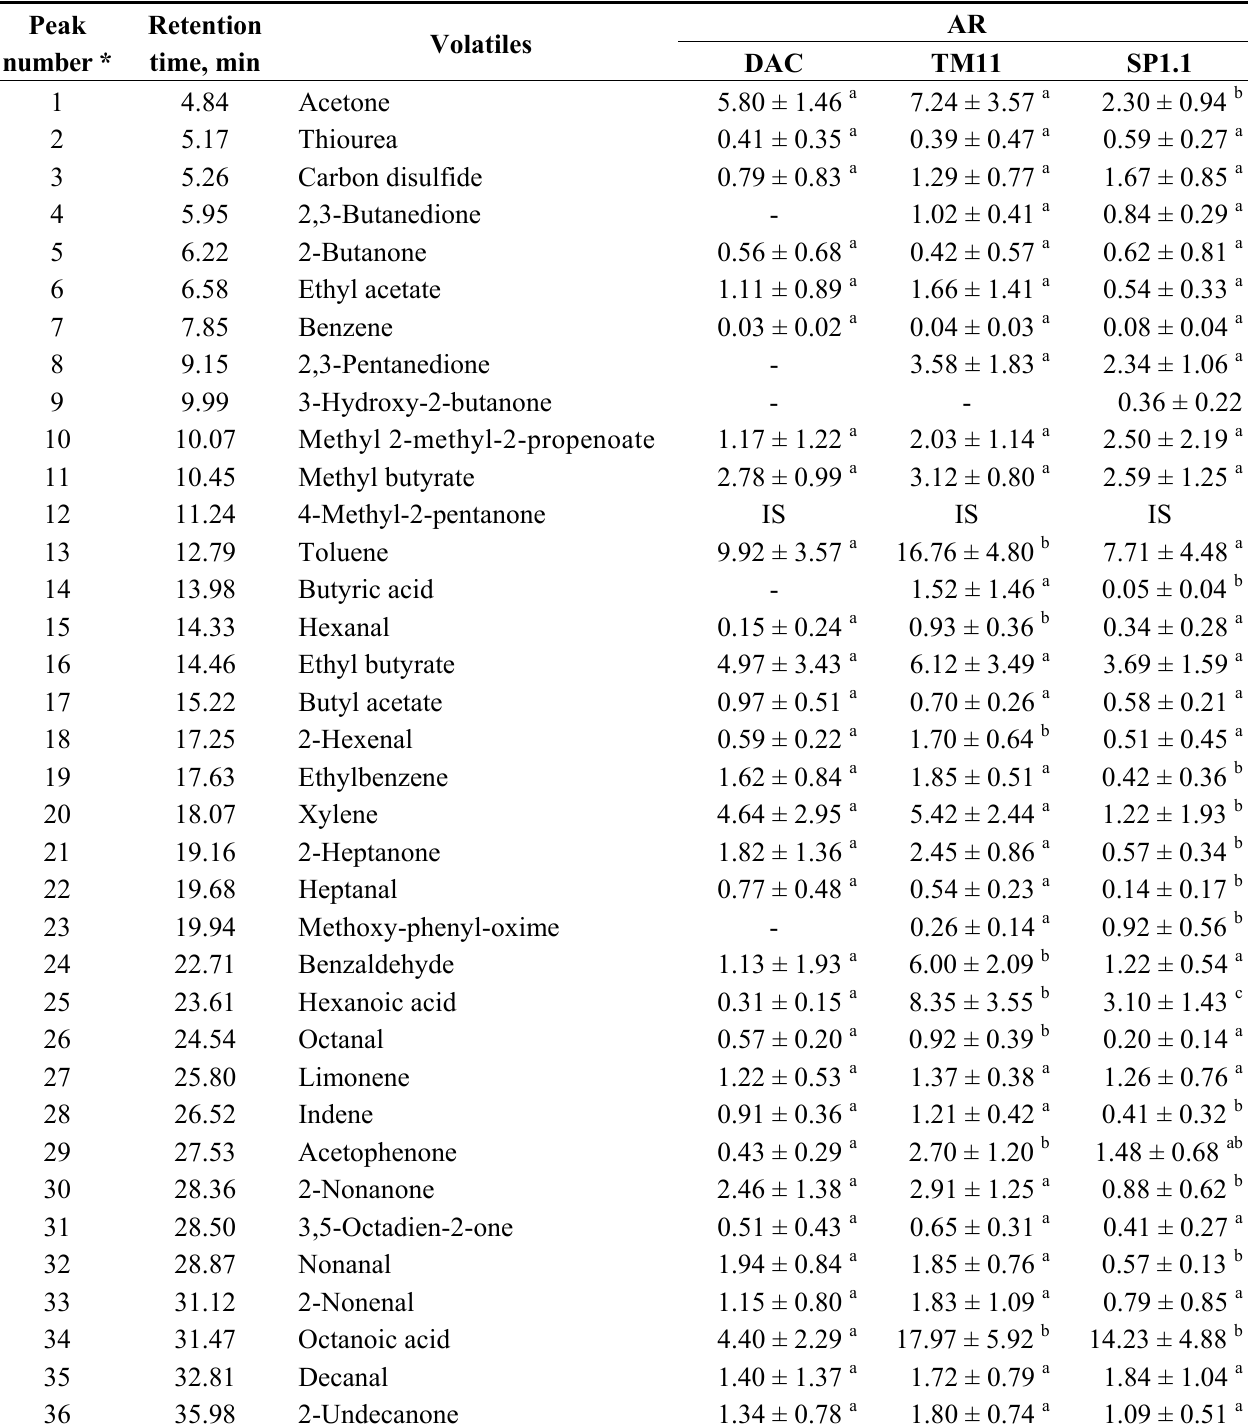
Table 2. Comparison of volatiles in the direct-acidified cheese (DAC) and the cultured cheeses with S. thermophilus (TM11 and SP1.1) on the day 45 of aging.